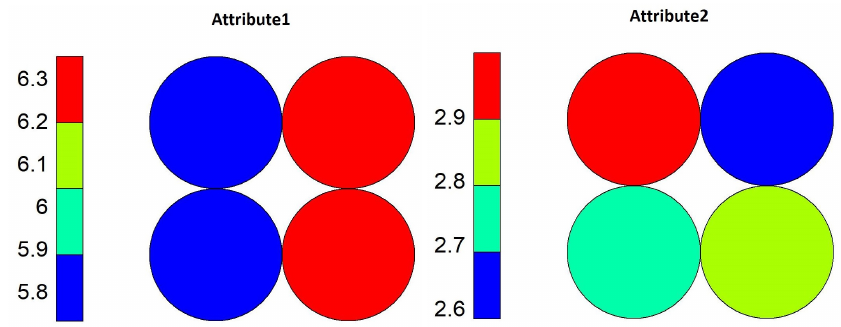
Figure 9. Variable heatmap—synthetic database, level 2, neuron